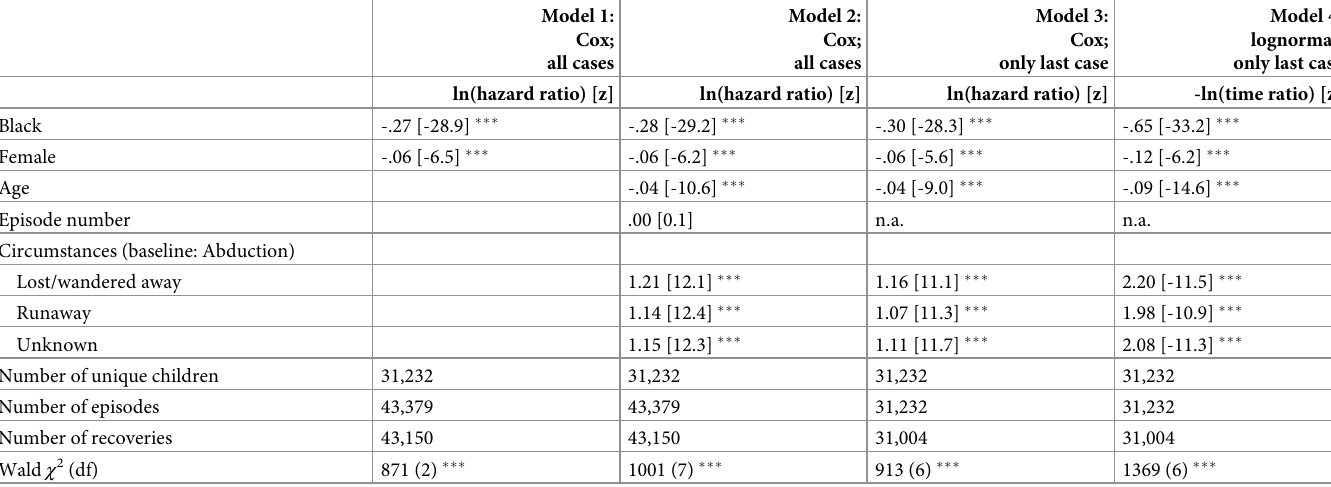
Table 3. Survival models regressing recovery hazard of missing children on race, gender, age, episode number, and